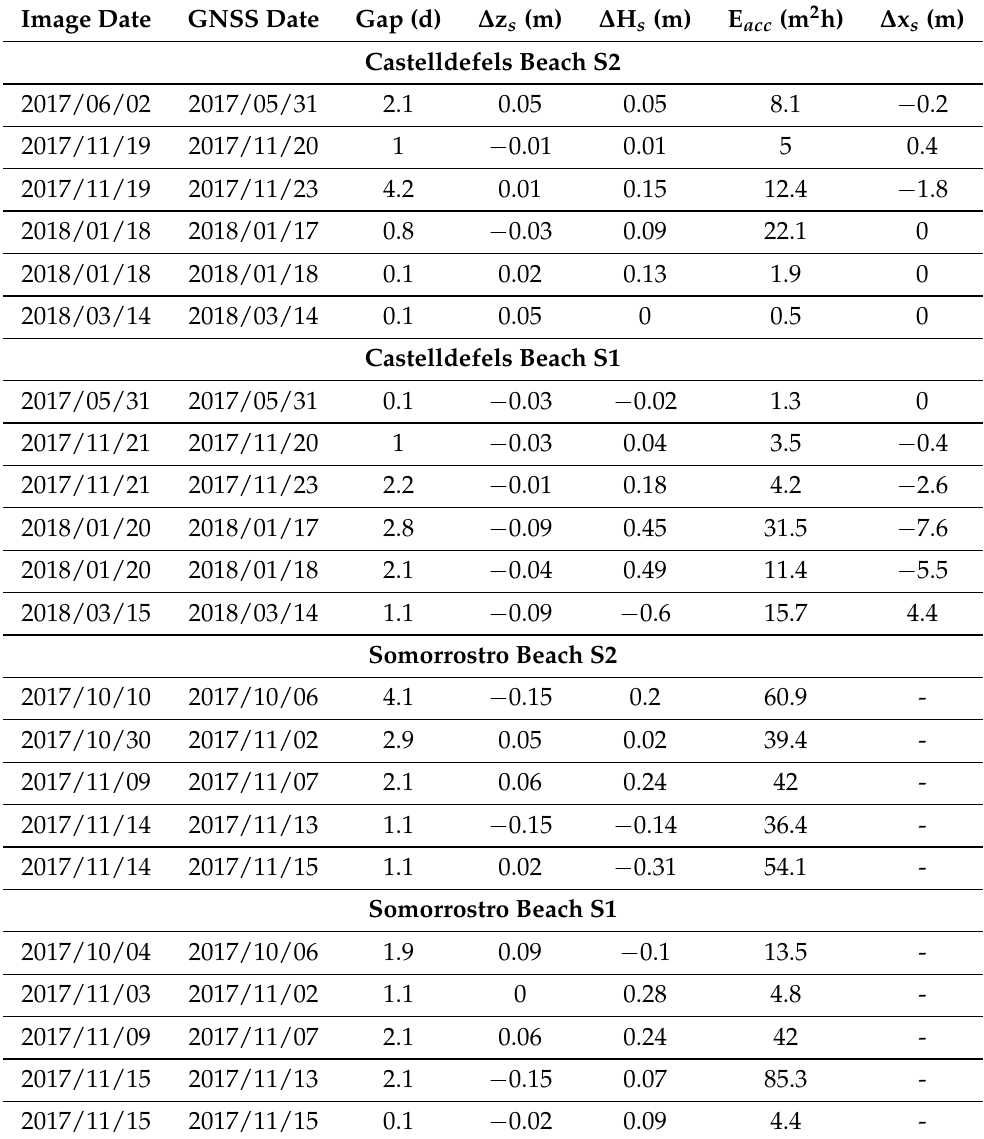
Table 9. Oceanographic conditions during the studied shoreline dates (of the satellite images and of the GNSS